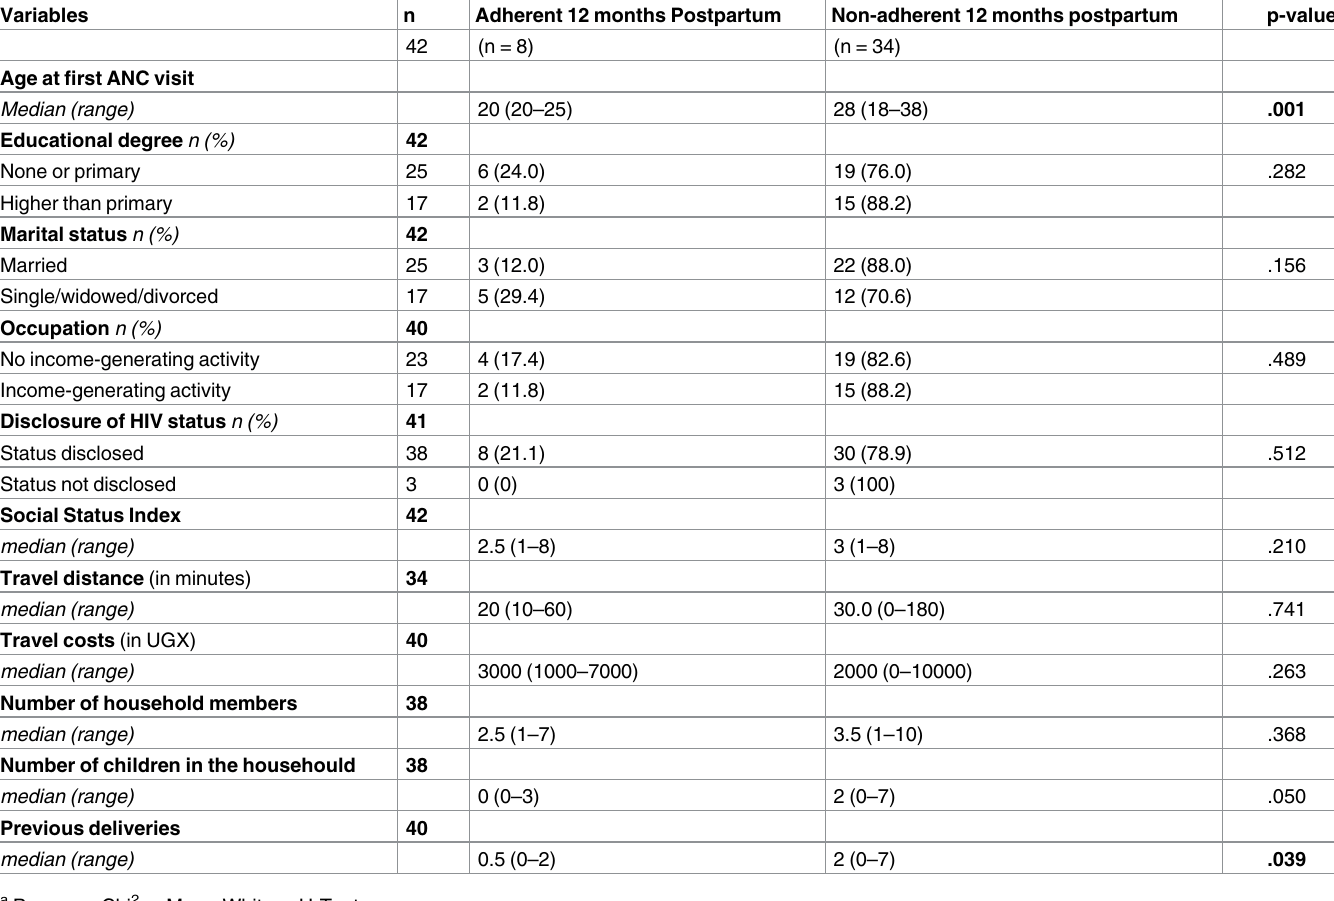
Table 3. Sociodemographic and clinical characteristics by adherence